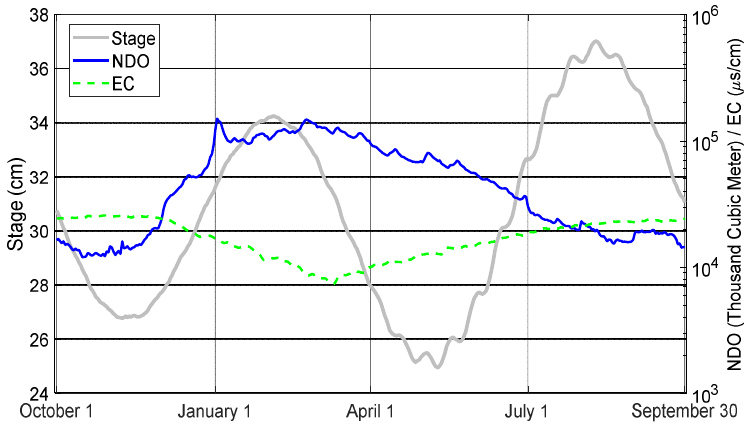
Figure 2. Long-term (water year 1991–2014) average daily Martinez water stage (Stage; left y -axis), net Delta outflow (NDO; right y -axis) and Martinez salinity represented by Electrical Conductivity (EC; right y -axis).